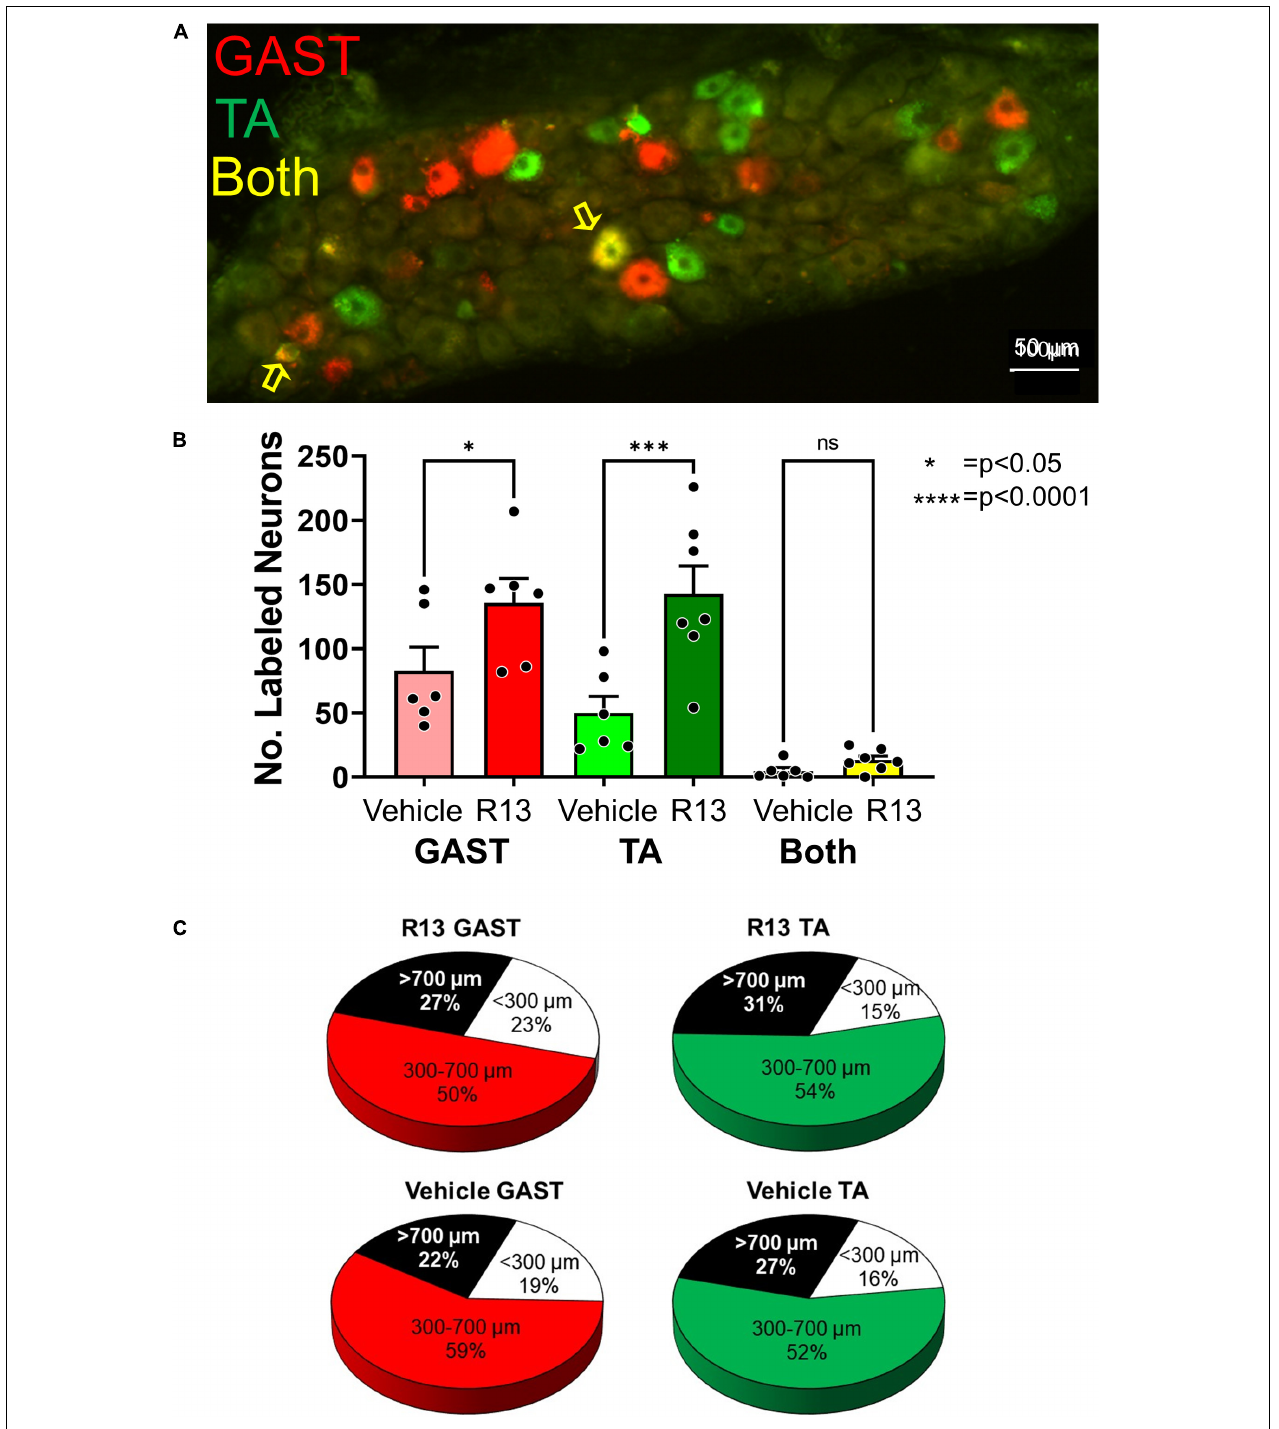
FIGURE 3 | Oral R13 treatments promote regeneration of muscle afferent neurons. (A) Histological section through an L4 dorsal root ganglion (DRG) from a mouse treated with R13. Cell bodies of primary afferent neurons successfully reinnervating the gastrocnemius (GAST, red) or tibialis anterior (TA, green) muscles 4 weeks after sciatic nerve transection and repair are shown. Sensory neurons labeled by both tracers (yellow) are indicated by the yellow arrows. (B) Counts of labeled neurons (mean ± SEM, n = 6) in the L4 dorsal root ganglia of vehicle-treated and R13-treated mice. (C) Mean proportions of labeled DRG neurons in different size classes in the two different treatment groups. No significant differences were found between R13-treated and vehicle-treated mice. * = p < 0.05, **** = p < 0.0001.